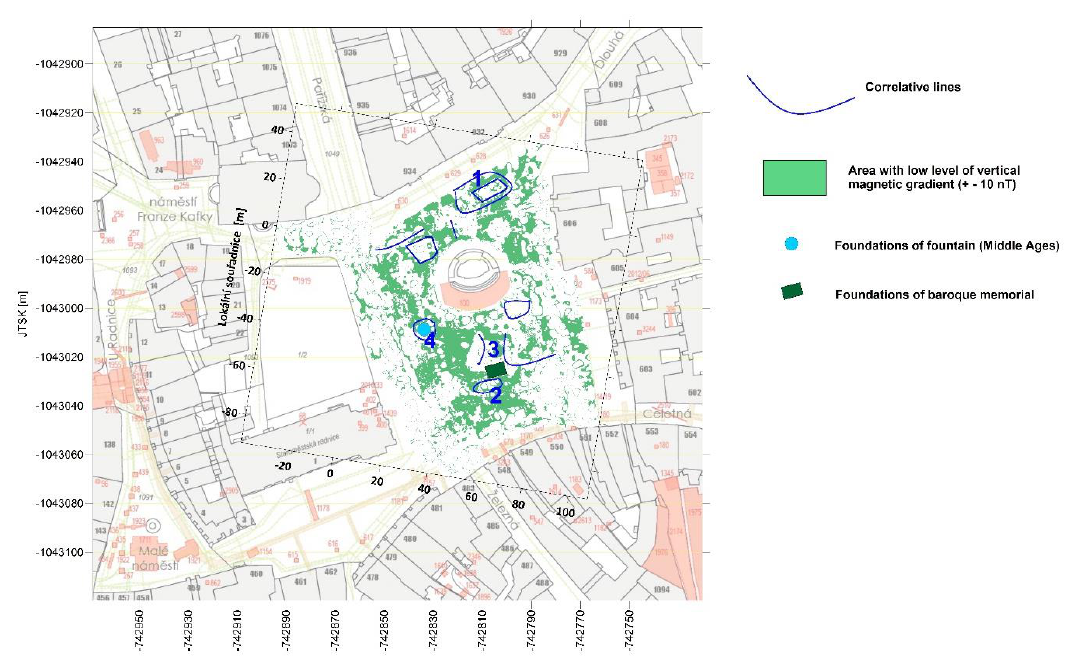
Figure 20. Old Town Square. The map of areas with low intensity values ( ± 100 gamma). Low values of the gradient are marked by green color, the other areas remain white. 1—Structure is probably an indication of so-far undiscovered marketplace; 2, 3 and 4 are probably traces of the activities around the defunct fountain (4) and Maria memorial (2, 3).